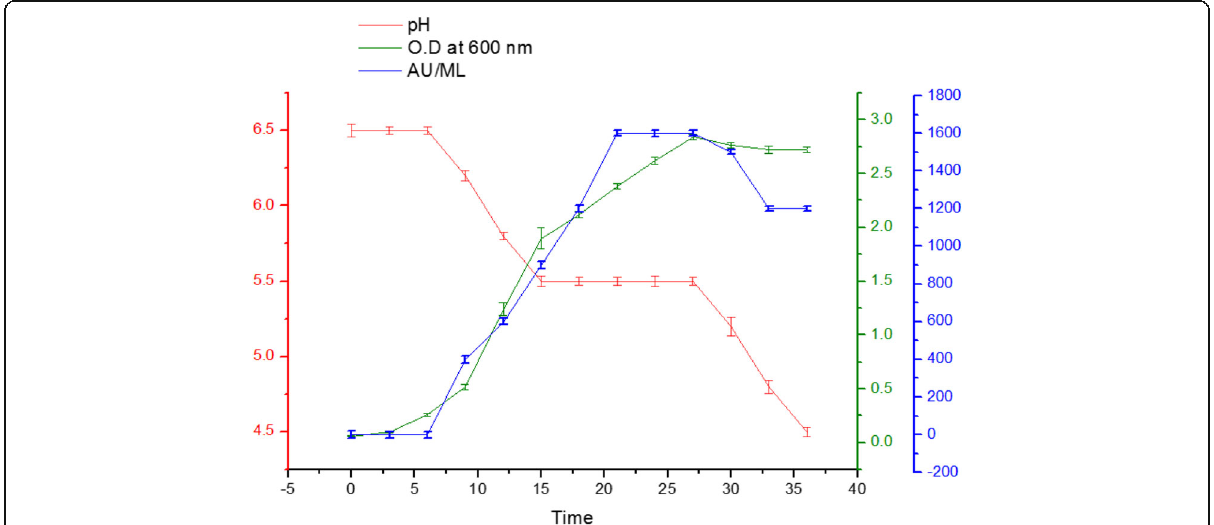
Fig. 3 Growth curve and bacteriocin production by Enterococcus casseliflavus MI001 strain